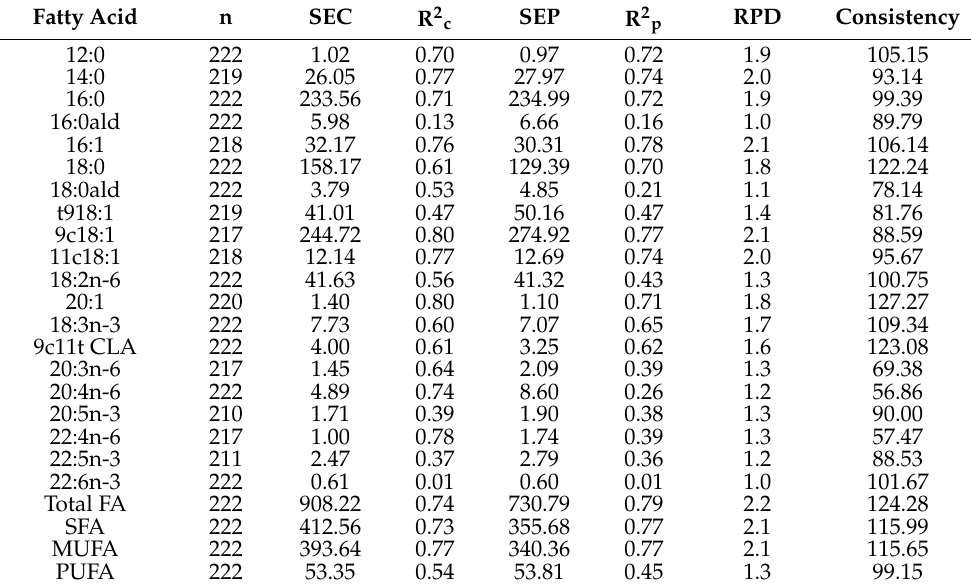
Table 6. NIRS calibration and validation statistics for the total fatty acid composition (mg FA/100 g of